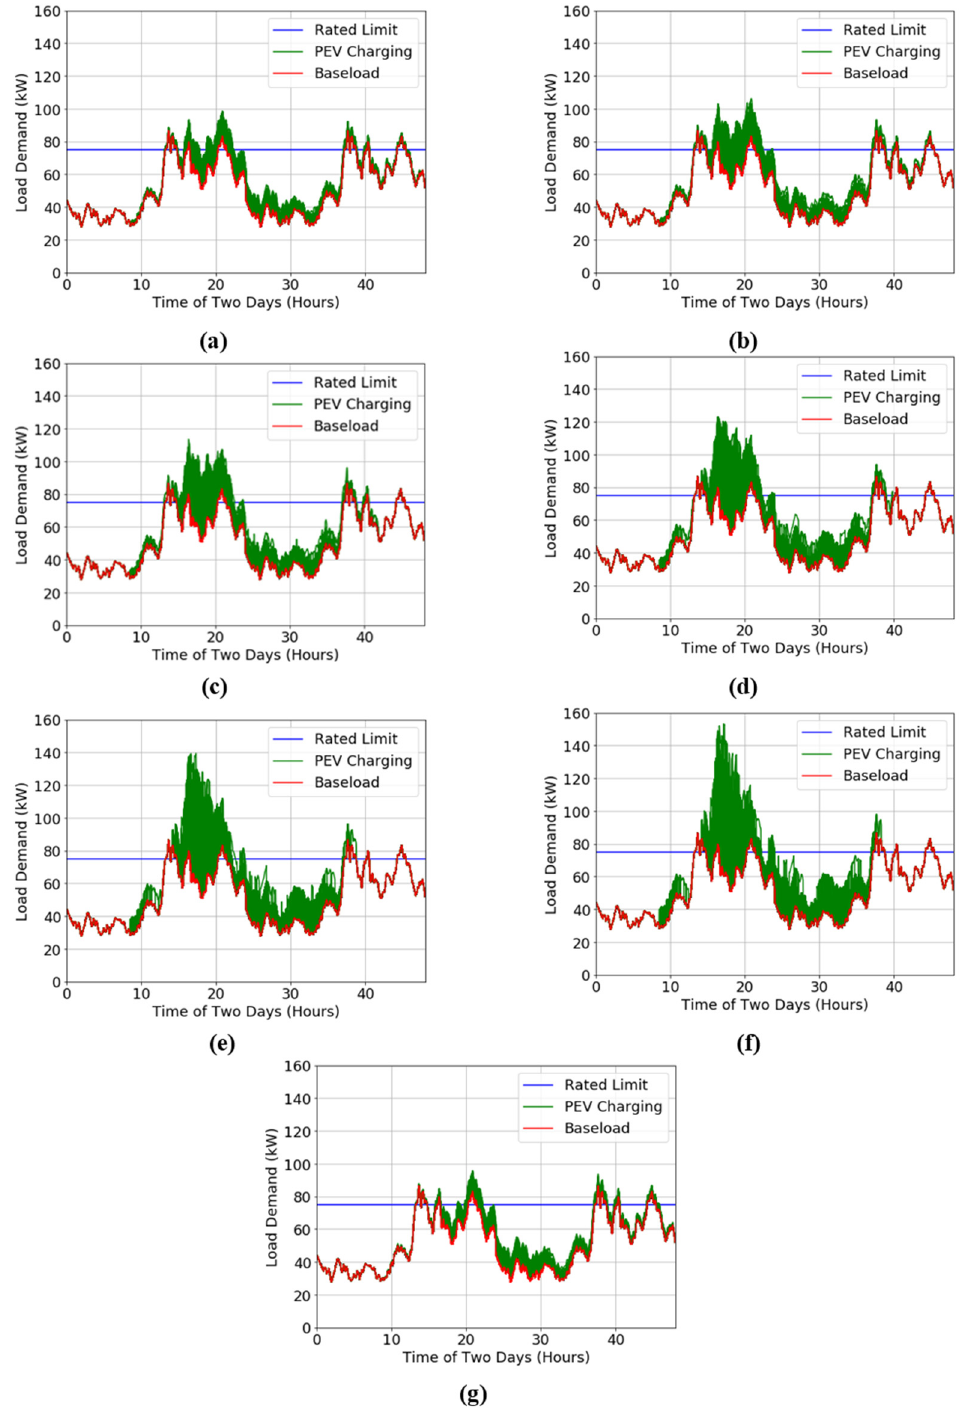
Figure 6. Charging profiles created from ( a ) 1.9 kW, ( b ) 3.3 kW, ( c ) 4.8 kW, ( d ) 7.2 kW, € 9.6 kW, ( f ) 11.5 kW, and ( g ) 0–11.5 kW uncontrolled